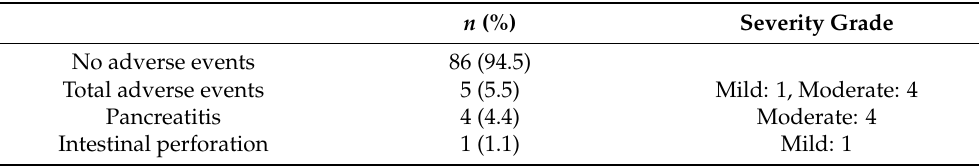
Table 5. Adverse events in patients undergoing ERCP ( n =